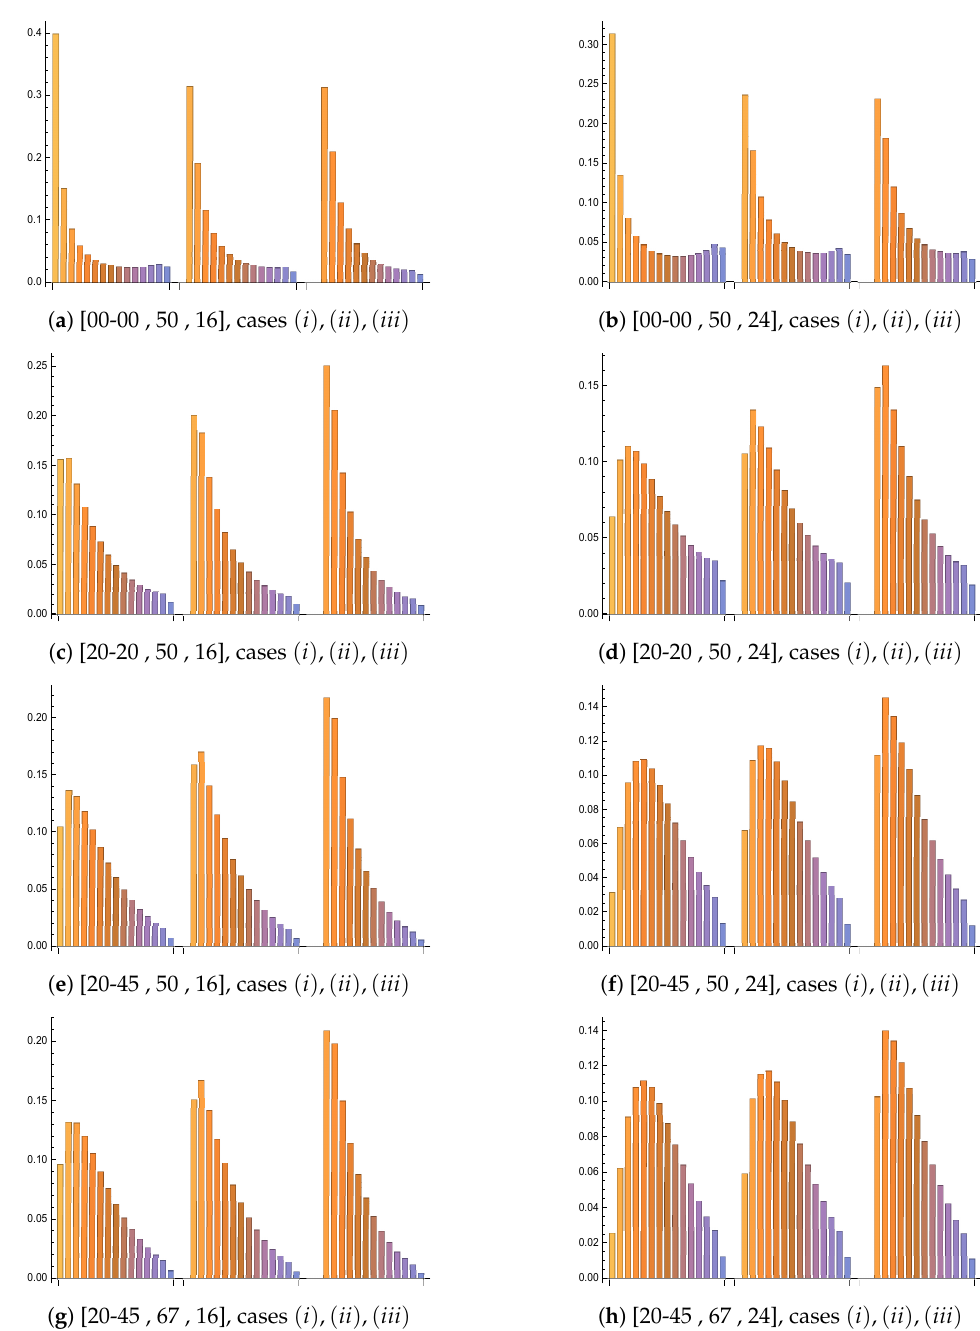
Figure 1. The three histograms in each of the panels ( a – h ) refer to the three cases ( i ) , ( ii ) , ( iii ) of the model quoted in the relative caption and represent the fraction of individuals in each of the non-empty income